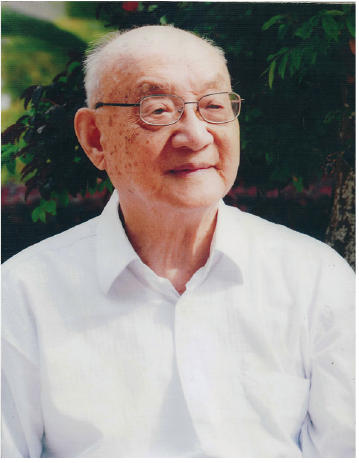
Figure 1. Dr. Jian-Kang Liu in 2014.